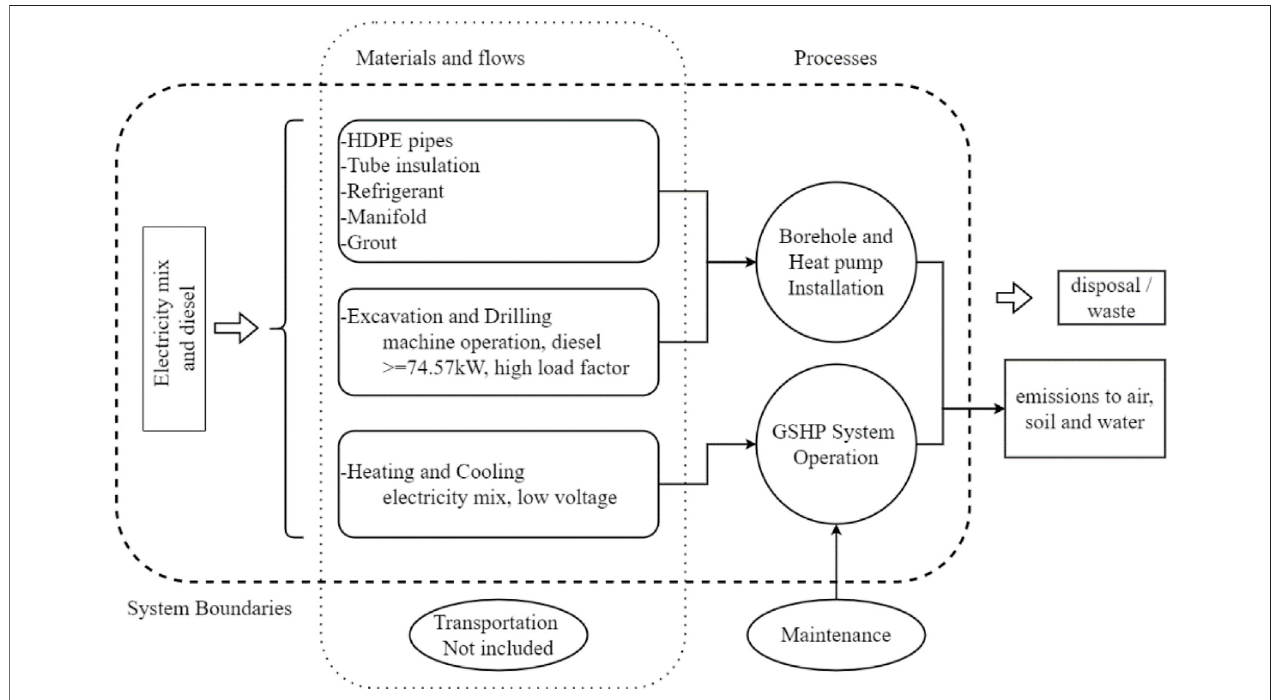
FIGURE 2 | LCA System boundaries for all GSHP systems under